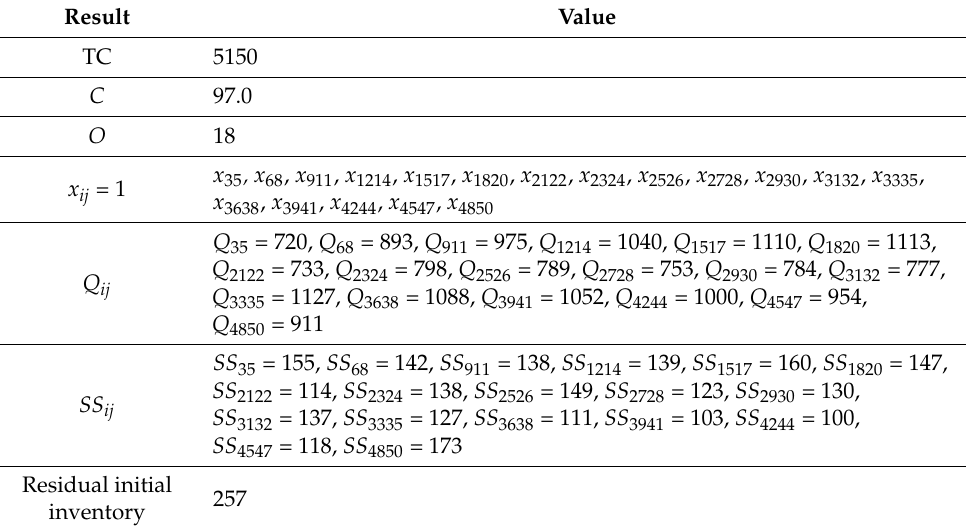
Table 2. Initial results.